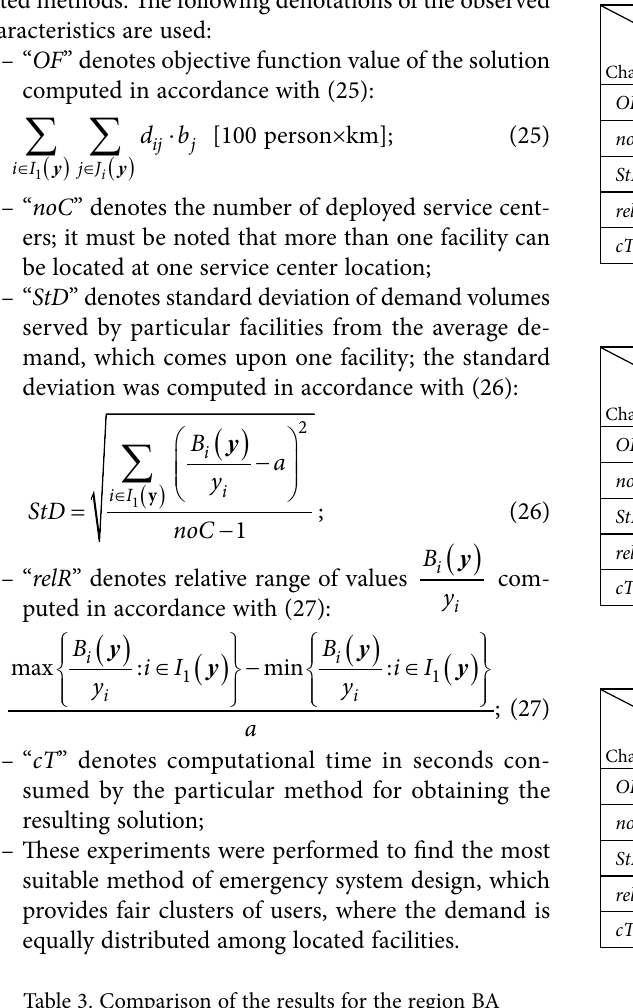
Table 3. Comparison of the results for the region BA Solution